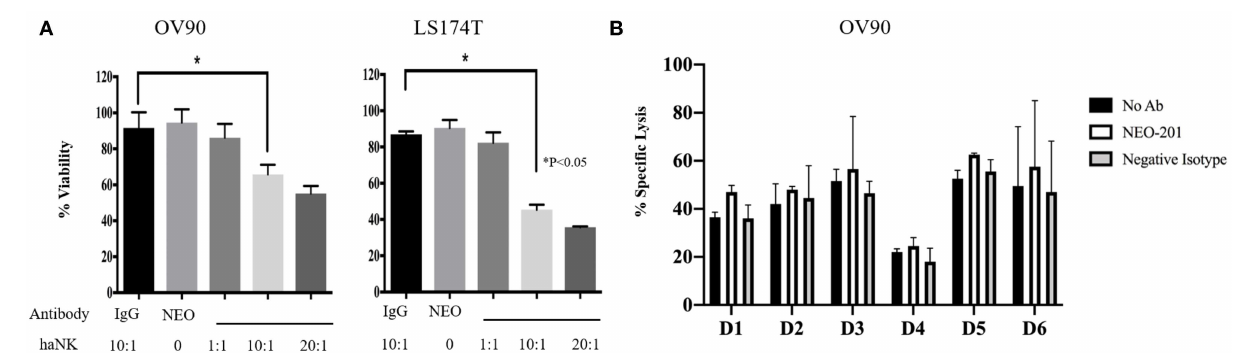
FIGURE 3 | NEO-201 decreases cell viability by activating natural killer (NK)-mediated antibody-dependent cellular cytotoxicity (ADCC) in vitro . (A) NEO-201-positive OV90 and LS174T cells lines were selected to assess the effect of NEO-201 on NK-mediated ADCC. Cells were incubated with either highly active natural killer (haNK), NEO-201 at a dose of 1 µ g/ml, or a combination of NEO-201 with haNK at different effector-to-target (E:T) ratios. ADCC activity was assessed by non-radioactive ADCC assay. Experiment and results from (A) were analyzed according to the Celigo program manufacture as described in the Material and Methods section. (B) In order to select the best NK human donor to use for in vivo experiments, the OV90 cell line was incubated with the NK isolated from the PBMCs from six different donors in the presence of 1 µ g/ml of NEO-201. To evaluate specific lysis, NK derived from a selected human donor were activated with IL-2 and used for the experiment in two different effector cells (E):target cells (T) ratios: 50:1 or 100:1. Chromium released assay was used to evaluated specific lysis. Experiments depicted in this figure reflect the mean ± SD of three independent experiments. Ordinary one-way ANOVA was used for statistical analysis. * P < 0.05.